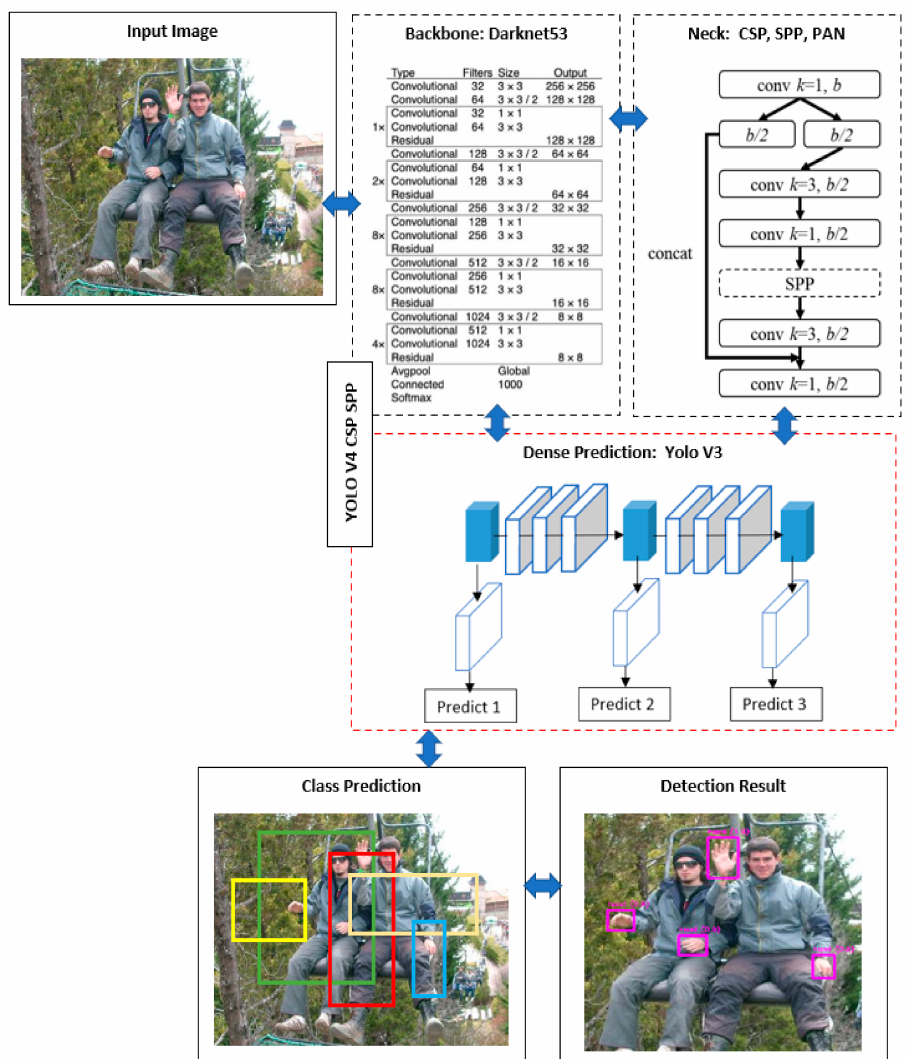
Figure 2. System architecture of Yolo V4 CSP SPP.